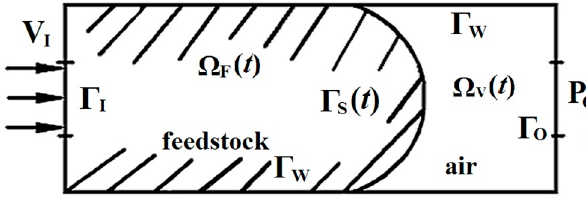
Figure 5. Modeling of injection moulding based on Eulerian description.